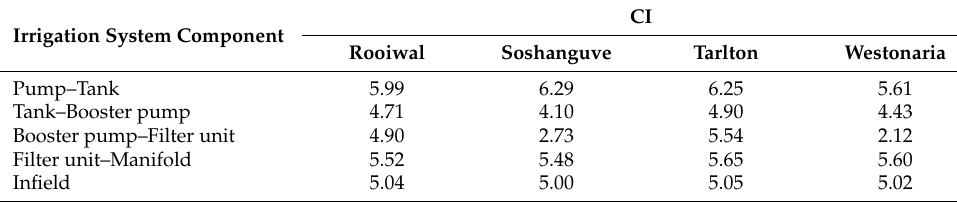
Table 2. Condition indices (CIs) for irrigation infrastructure components at the Agri-Parks, Gauteng province (February–March